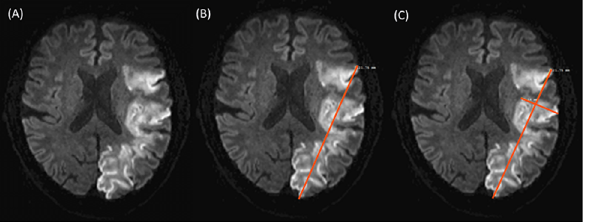
Fig 2. Illustration of the od-value calculation. (A) Shows the DWI slice with the largest lesion diameter. (B) Demonstrates how the maximal diameter of the lesion was measured on this slice. (C) Shows how a second perpendicular diameter was measured, again choosing the maximum length. In this infarct of 95 ml volume, the multiplication of the two values results in an od-value of